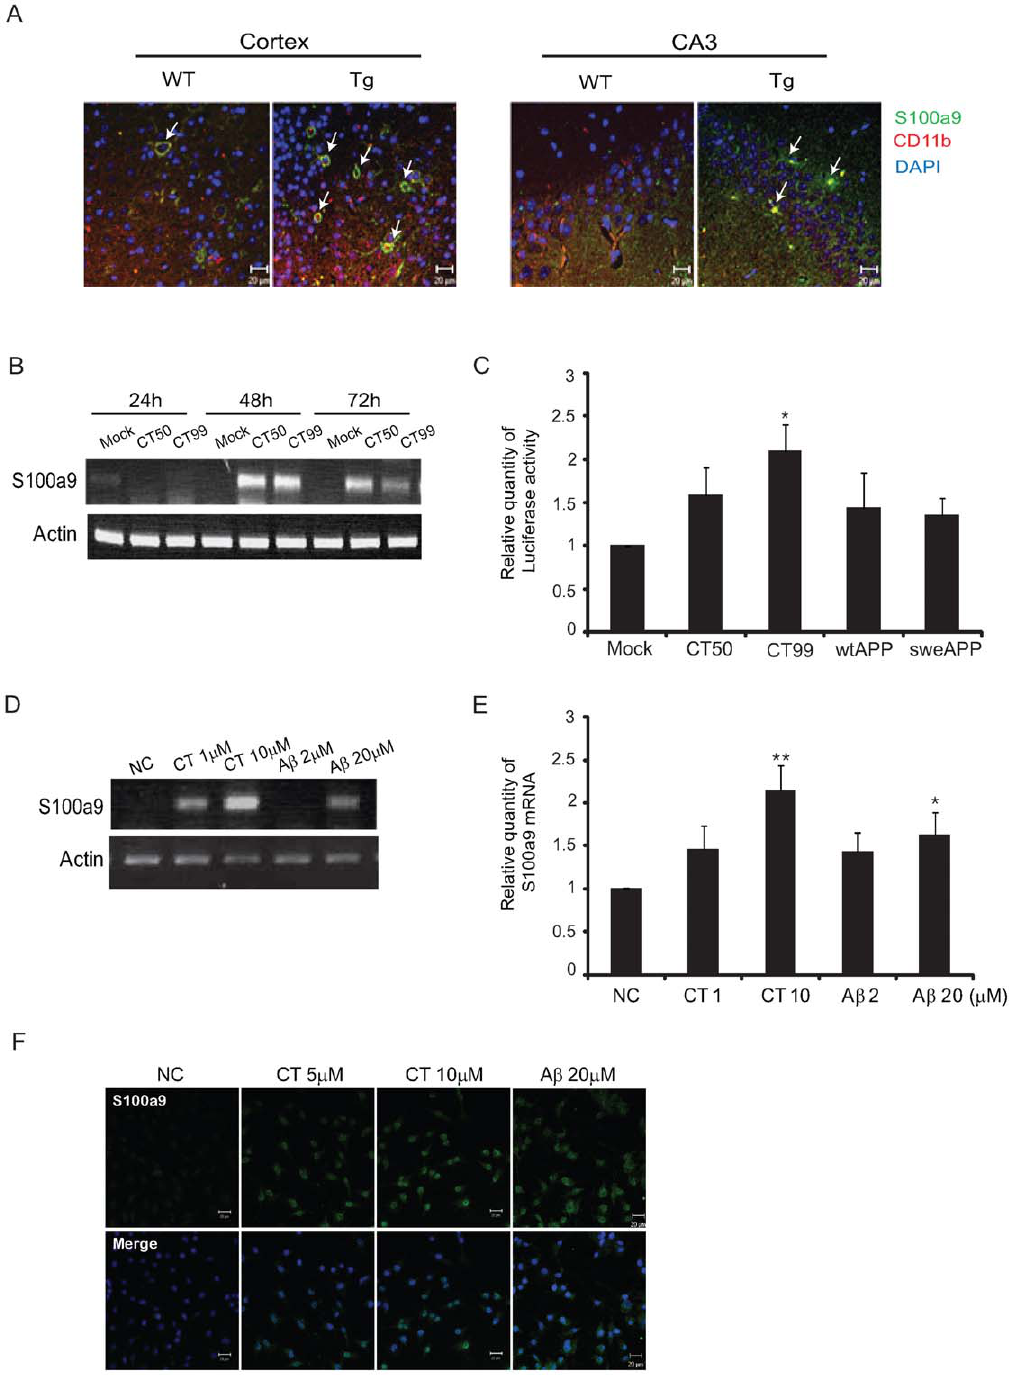
Figure 2. A b and CT induced S100a9 expression in BV2 cells. (A) Immunostaining for S100a9 (green) and CD11b (red) was performed in the cortex and CA3 of Tg and wild-type mouse brains. DAPI (blue) staining indicates the nuclei. Scale bars represent 20 m m. WT and Tg represent wild- type control and transgenic animals, respectively. (B) The mRNA levels of S100a9 were checked at 24 h, 48 h, and 72 h post-transfection with CT50 or CT99 by RT-PCR. (C) Human S100a9 promoter in pGL3 vector was cotransfected with CT, wtAPP or sweAPP in pcDNA vector and fe65 into SHSY5Y cells. 48 h after transfection, luciferase reporter assays were performed for CT50, CT99, wtAPP and sweAPP, the four S100a9 targets. Luciferase activities were normalized versus the obtained protein concentrations. The histogram shows the ratio of luciferase activity in transfected cells to empty vector-transfected cells (n=5). (D) RT-PCR of S100a9 induced at 48 h post-treatment with 1 m M and 10 m M CT or 2 m M and 20 m M A b . (E) The quantification of RT-PCR normalized to actin (n=8). (F) Immunocytochemistry; BV2 cells grown on a glass coverslip were treated with CT (5 m M and 10 m M) and A b (20 m M) for 48 h. S100a9-positive cells were visualized with FITC (green)-conjugated secondary antibodies. Nuclei were counter- stained with DAPI (blue). Scale bars represent 20 m m. All data are presented as the means 6 SEM. *P , 0.05, **P , 0.01 by Student’s t –test.